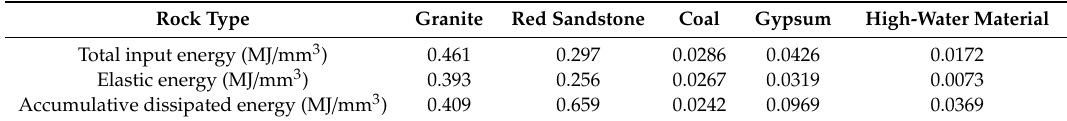
Table 3. Strain energy density at peak point for the five rock materials.